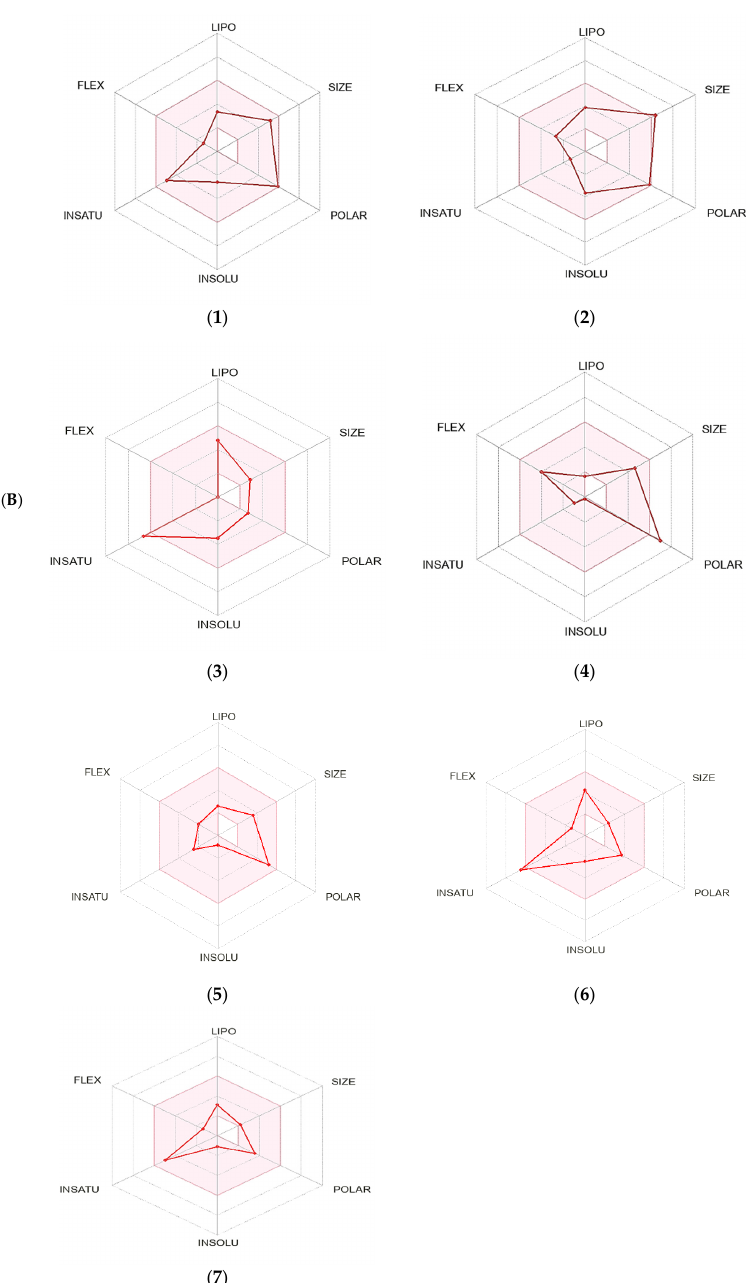
Figure 7. A boiled egg diagram ( A ) and bioavailability radar ( B ) for compounds 1: ouabagenin; 2: corchoroside A; 3: xanthyletine; 4: prenyl arabinosyl-(1->6)-glucoside; 5: furaneol 4-glucoside; 6: methyl orsellinate; and 7: ginkgotoxin. A boiled egg diagram represents the passive gastrointestinal absorption (HIA) and brain penetration (BBB) in the function of the position of the molecules in the WLOGP-versus-TPSA referential. The white region is for a high probability of passive absorption by the gastrointestinal tract, and the yellow region (yolk) is for a high probability of brain penetration. Yolk and white areas are not mutually exclusive. In addition, the points are colored in blue if they are predicted as actively effluxed by P-gp (PGP+) and in red if they are predicted as a non-substrate of P-gp (PGP − ). The bioavailability radar represents the drug-likeness of a molecule, with the pink area representing the optimal range for each property (lipophilicity: XLOGP3 between − 0.7 and +5.0; size: MW between 150 and 500 g/mol; polarity: TPSA between 20 and 130 Å2; solubility: log S not higher than 6; saturation: fraction of carbons in the sp3 hybridization that is no less than 0.25; and flexibility: no more than nine rotatable bonds for